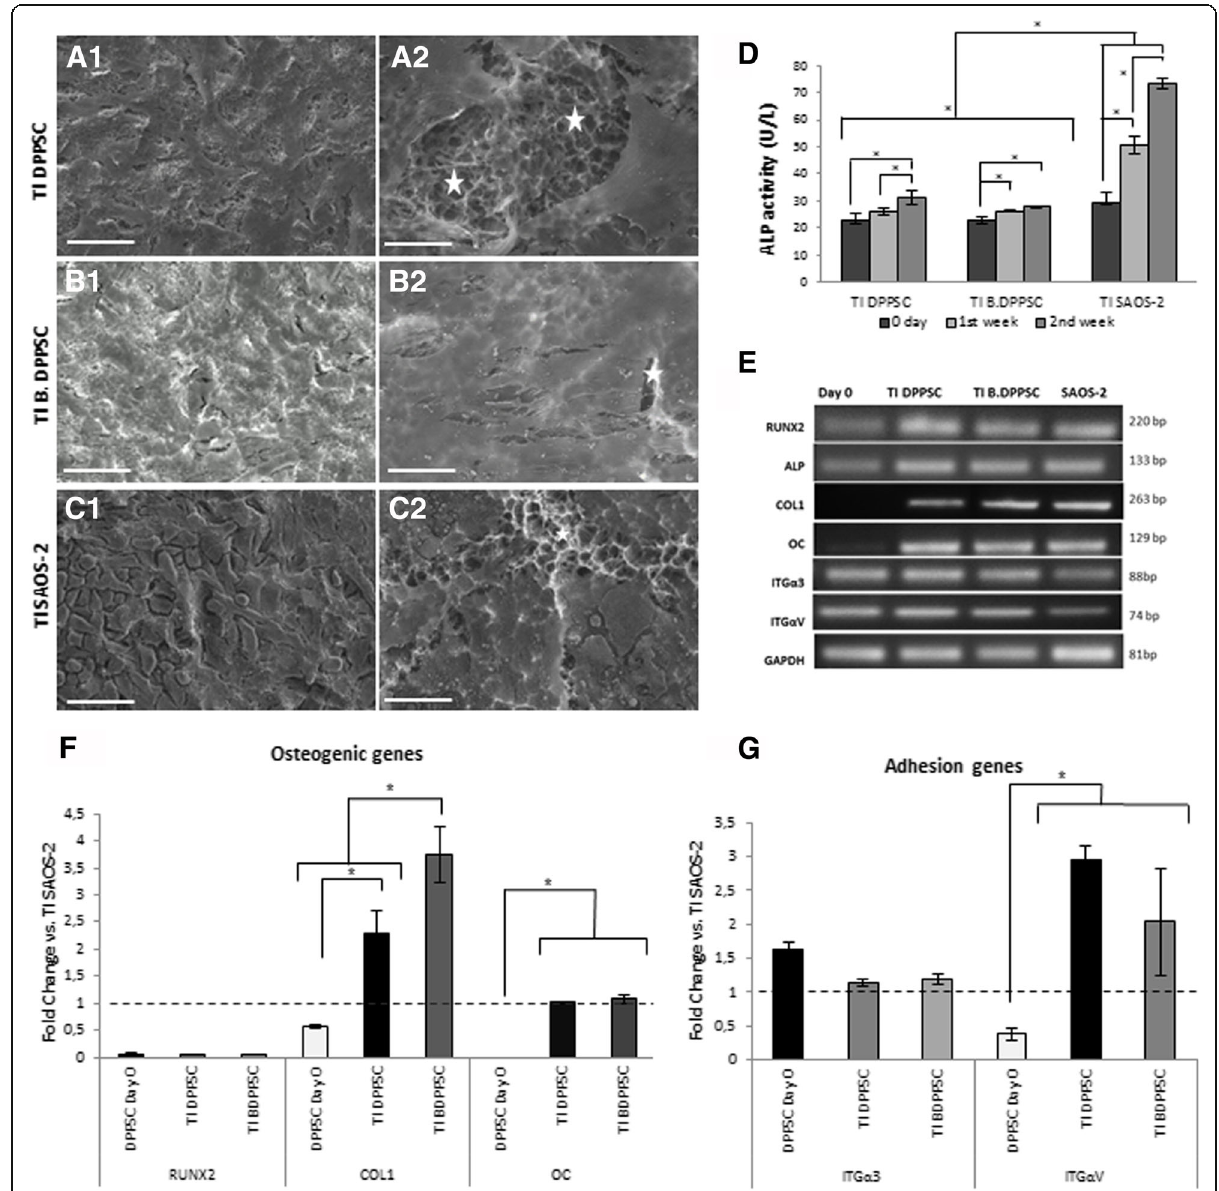
Fig. 6 Osteogenic differentiation on Ti disks. a-c SEM images of the different cells types differentiating on Ti alloy disks. ( a ) DPPSC, ( b ) Bone-like DPPSC, ( c ) SAOS-2. Stars indicate the Ti surface without cells. Scale Bars: 40 μ m ( a1 , b1 , c1 ), 10 μ m ( a2 , b2 , c2 ). d ALP activity (U/L) of TI DPPSC, TI B.DPPSC and TI SAOS-2 differentiating on Ti alloy disks at week 1 and 2 ( n = 3). e - g RT-PCR ( e ) and qRT-PCR ( f , g ) gene expression analysis of differentiation (RUNX2, COL1 and OC) and adhesion markers (ITG α 3 and ITG α V) at second week of cell differentiations on Ti alloy disks ( n = 3). TI SAOS-2 was used for normalization. DPPSC at day 0 of differentiation were used as a negative control and GAPDH was used as housekeeping gene. *P <